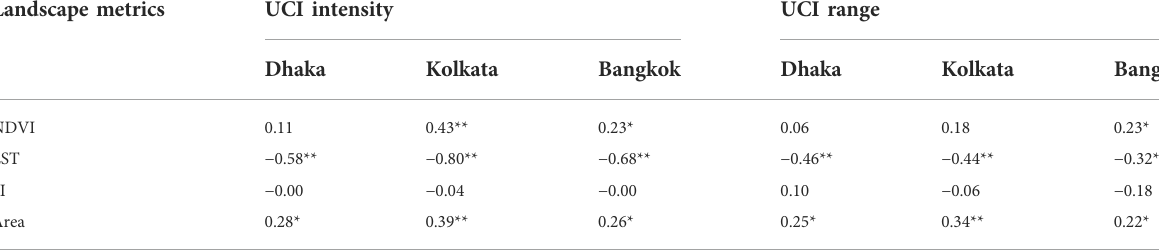
TABLE 6 Pearson correlation coef fi cients between the cooling effect and landscape metrics. Landscape metrics